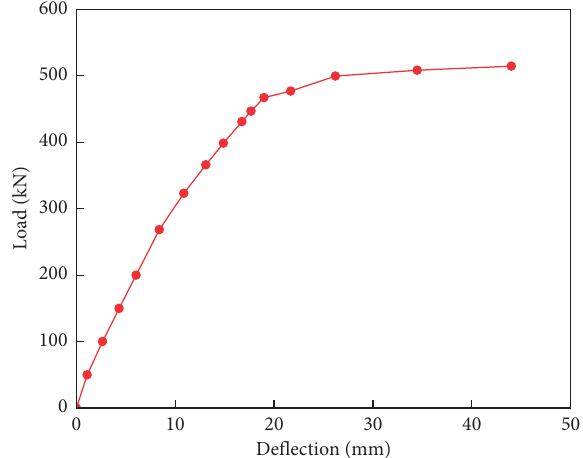
Figure 8: Load-midspan deflection